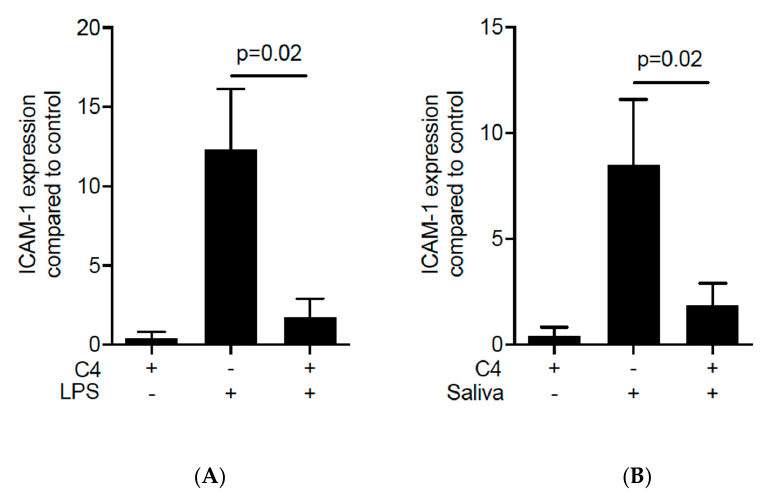
Figure 3. Butyrate suppresses the LPS- and saliva-induced increase of ICAM-1 in primary mouse macrophages. Cells were exposed to 10 mM of butyrate (C4) in the presence of ( A ) 100 ng/mL of LPS and ( B ) 2% saliva. ( + ), indicates presence; ( − ), indicates absence. Data represent the mean change of ICAM-1 expression ± standard deviation. n = 4. Statistical analysis was based on Mann–Whitney U test and p -values are indicated.